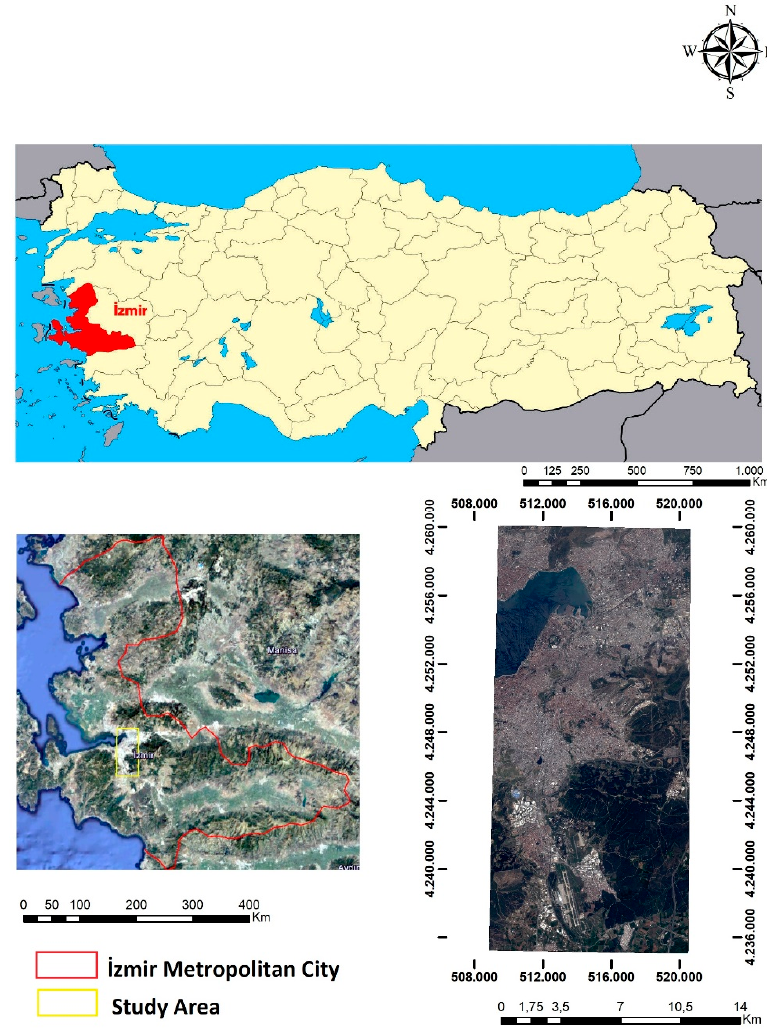
Figure 1. Study Figure 1. Study area.